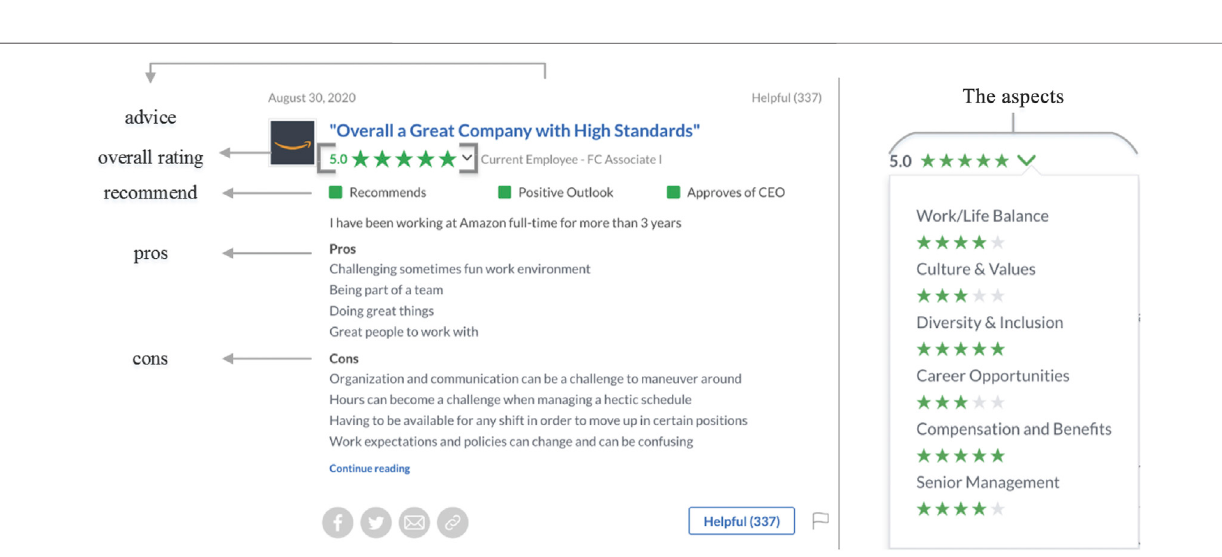
FIGURE 3 | An example of the employee review information on Glassdoor.com. In the numerical reviews, it is noted that the aspect of diversity and inclusion just appeared after August 2020, so we did include it in this study.